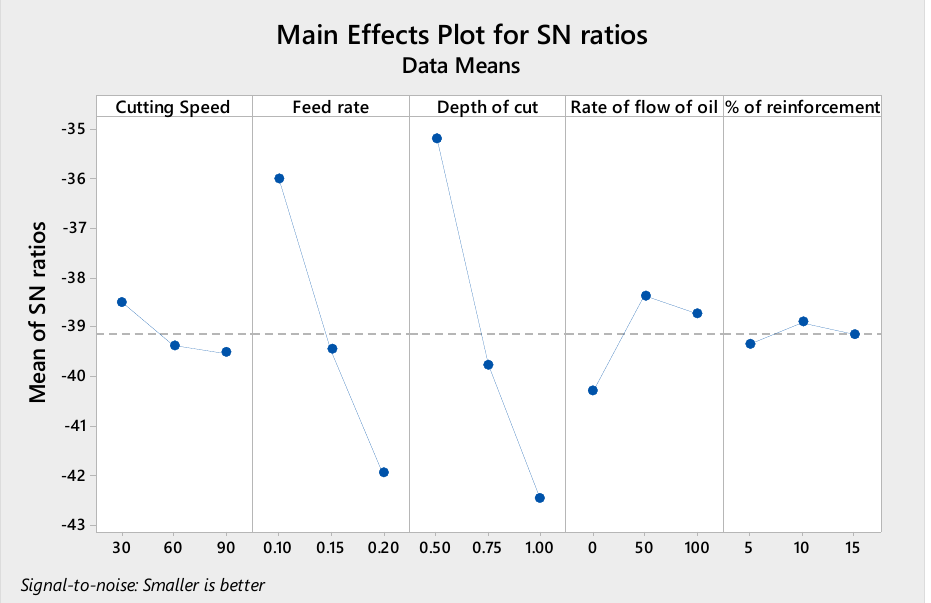
Figure 9. S/N ratio plots for cutting force.